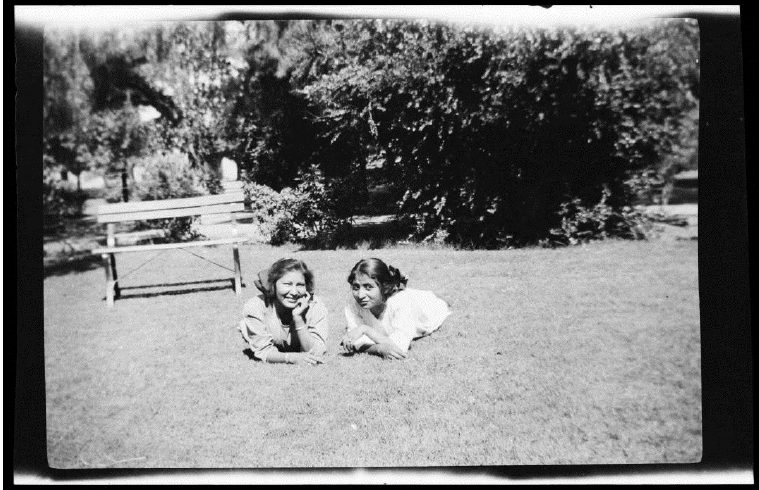
Figure 8. Nettie Odlety and Francis Ross. 1915. Photograph by Parker McKenzie. Parker McKenzie Collection. Courtesy of the Oklahoma Historical